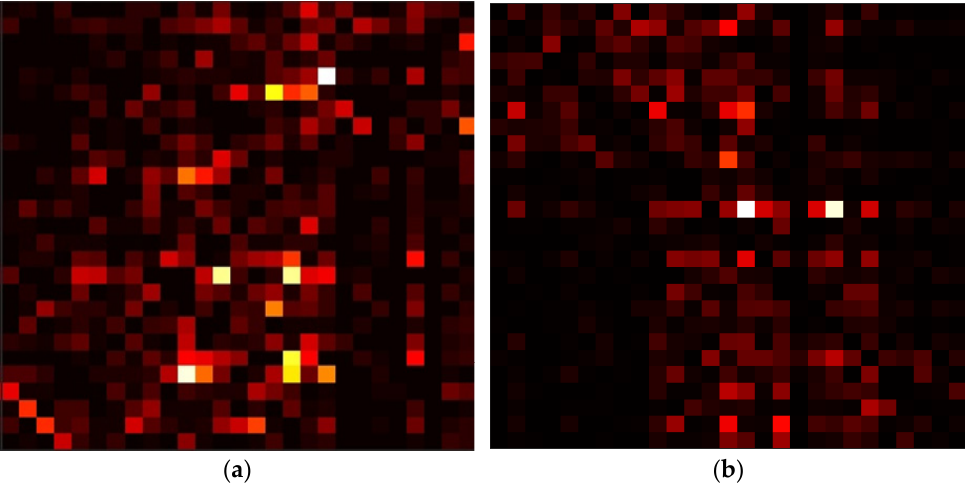
Figure A4. ( a ) Subject 11 ′ s DC of healthy class in alpha band, ( b ) Subject 10 ′ s (Total UPDRS = 22) DC of Parkinson class in alpha band.